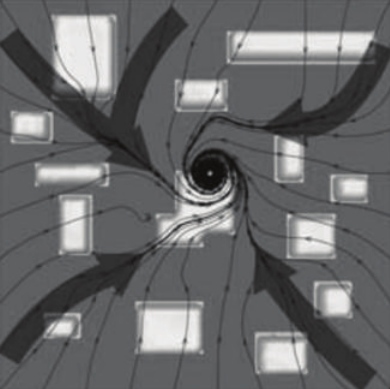
Figure 6: Image of a computer simulation showing how randomly oriented heat sources could cause a fire whirl through plume interactions. View is from above and heat sources are in lighter color (from Zhou and Wu [23]).